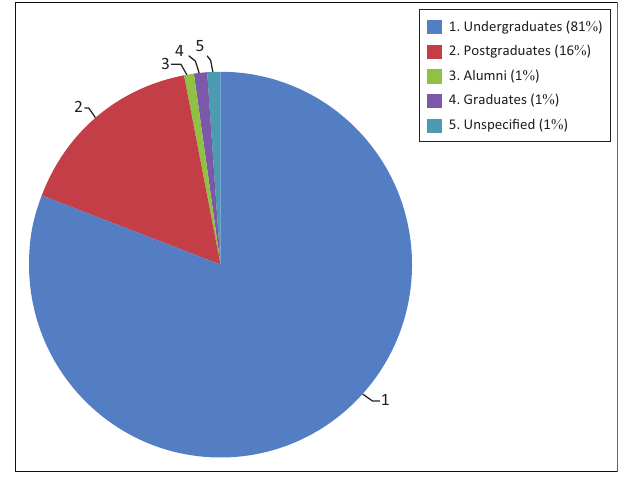
FIGURE 2: Level of study of the participants.